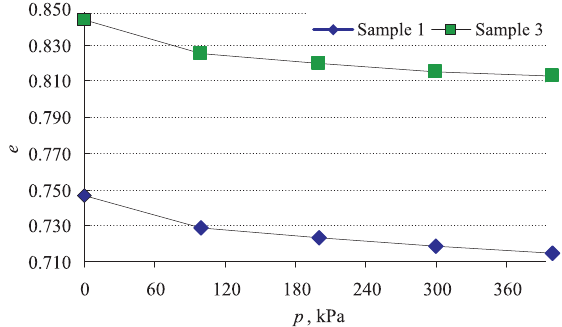
Fig. 5. Void ratio vs. loading for Sample 1 and 3